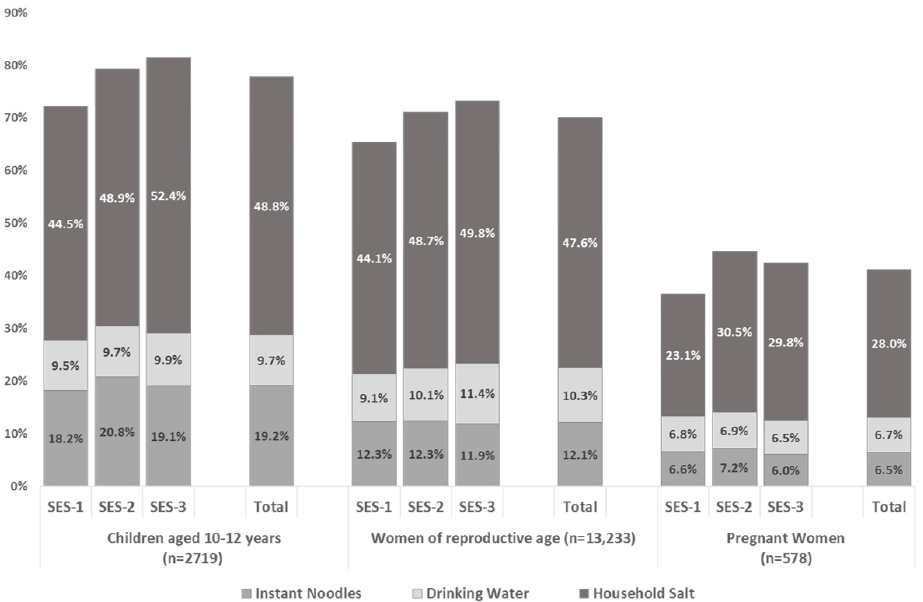
Figure 2. Estimates for the percent contribution to the iodine recommended nutrient intake (RNI) from iodised salt in instant noodles, household salt iodine and from trace iodine in non-packaged drinking water, according to respondent group and household socio-economic status (SES). SES-1 indicates the lowest status, SES-3 indicates the highest status. The estimates are based on iodine RNIs of 120 µg, 150 µg and 250 µg for SAC, WRA, and PW, respectively [22].